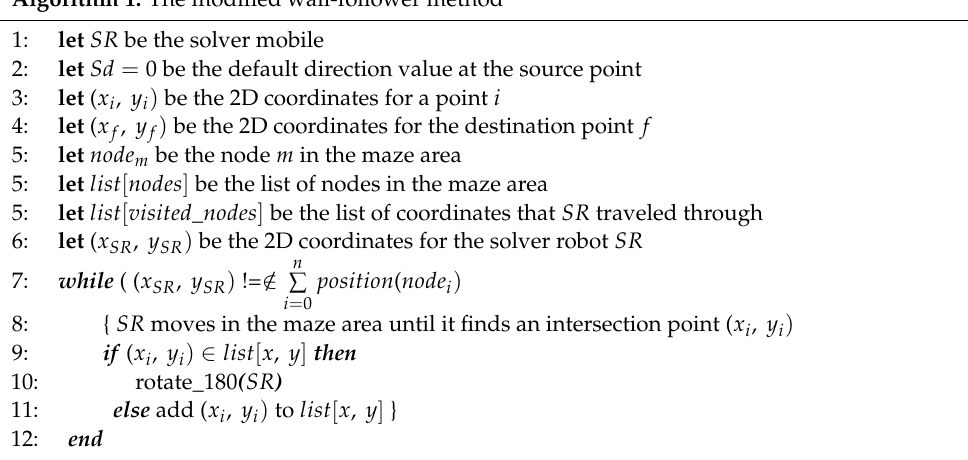
Algorithm 1: The modified wall-follower